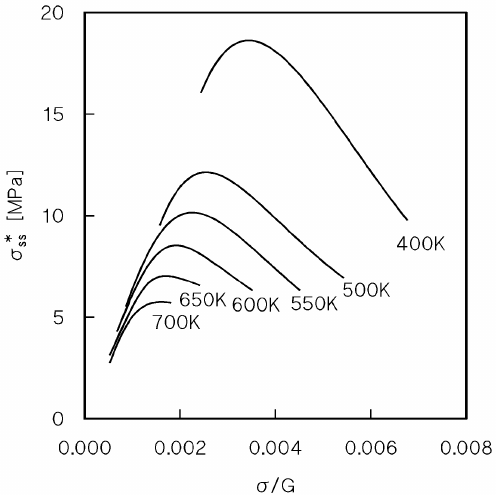
Figure 6. Description of the experimental data from [4] ( a ) and [16] ( b ) by Equations (10) and (11), with σ ∗ ss from Equations (21)–(24). Figure 6a also shows the variation of n = ∂ log with 3.24%Mg.